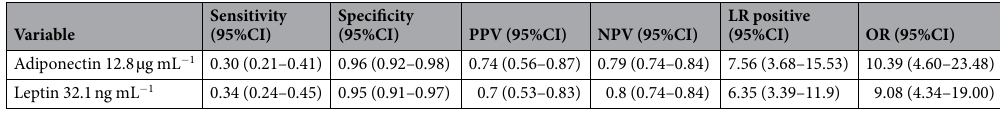
Table 3. Measures of Performance of Adipokines to Predict the PTS. Based on the optimal cut-off levels of adipokines as predictors of PTS that were determined based on the receiver operating characteristic (ROC) curves. PPV, positive predictive value; NPV, negative predictive value; LR, likelihood ratio; other abbreviations see Tables 1 and